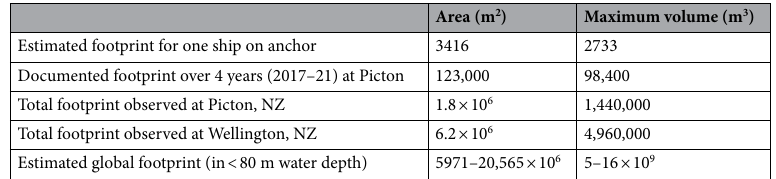
Table 1. Calculations of seabed area and volume disturbed by anchors based on observations from Picton and Wellington anchorages. See methods and Supplementary Table 1 for detailed